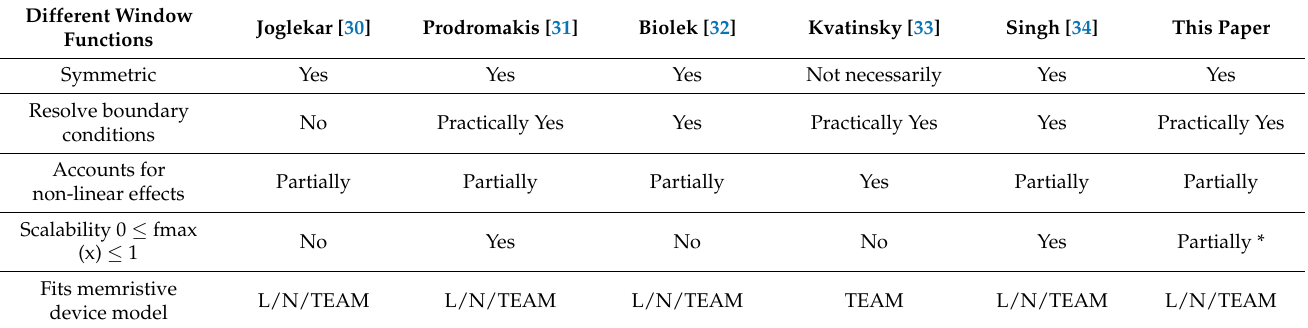
Table 1. Comparison between different window